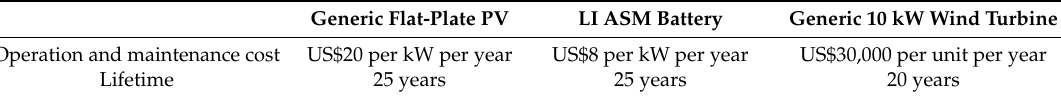
Table 1. Details of the model components for Zagazig.